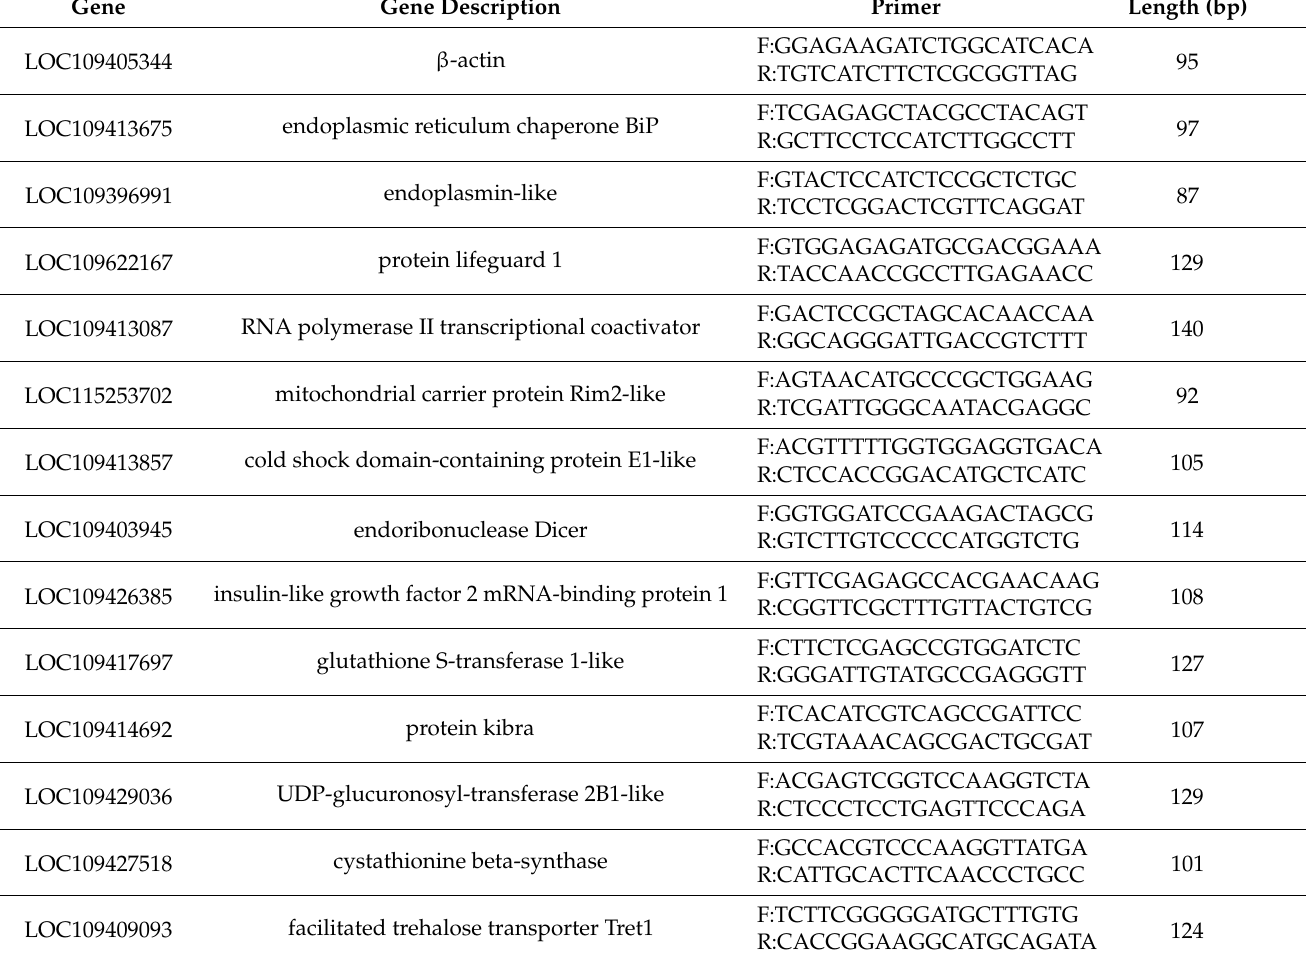
Table 1. Primer sequences of selected mRNA transcripts and the reference